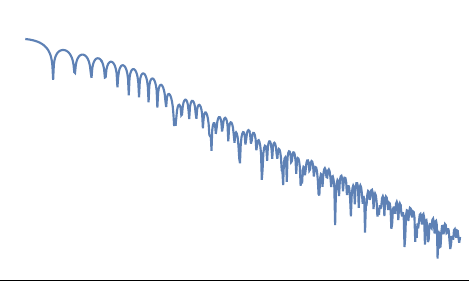
Figure 4. The Fourier transform of the function X ( t ) from figure 3(c), plotted in log scale against | x | 1 /s where s = 1 + 1 /r = 2 . The expected exp( − C | x | 1 /s ) decay is visible. (cid:0) α i (cid:1) . We estimate the ∂ β derivative on the support of χ ( k ) − χ ( γk where Q = Q d β i =1 β i